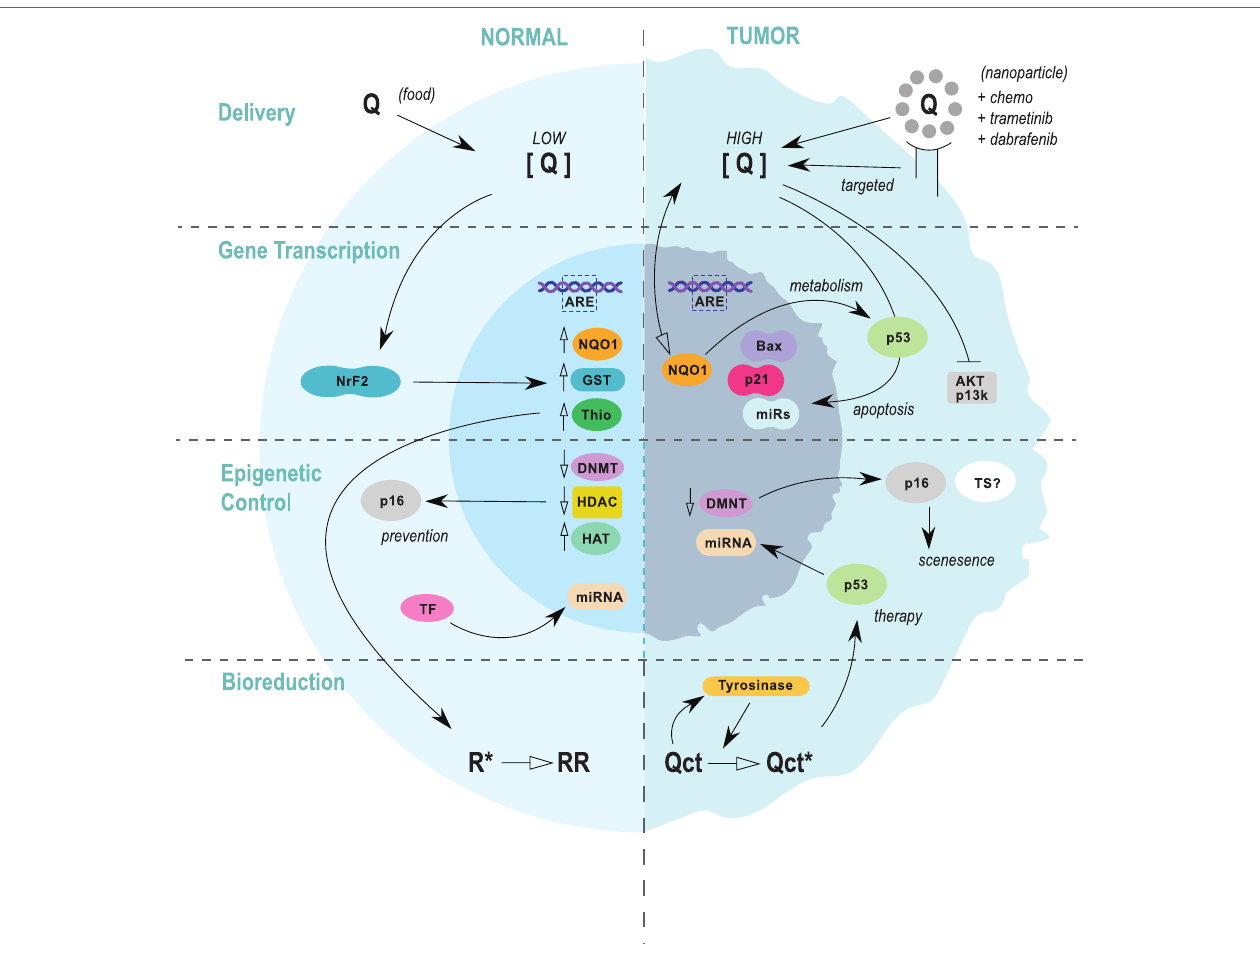
FigURe 3 | Summary of the four focus areas to develop quercetin as a chemo-preventative or therapeutic agent . In melanoma prevention scenarios (left), quercetin would be ingested through food sources and the concentration in normal melanocytes would be relatively low. Antioxidant activities and signaling pathways leading to the induction of cytoprotective proteins would dominate. Evidence suggests that quercetin may impart transcriptionally permissive epigenetic modifications within key tumor suppressor genes, including p16, which could confer resistance to oncogenesis. Induction of miRNAs could also aid in cancer prevention. In therapeutic protocols (right), quercetin would be delivered alone or in combination with anti-melanoma pharmaceuticals. Quercetin and additional compounds could be delivered through nanoparticles targeted to melanoma cells, or in an untargeted regimen. Pro-oxidant effects would be desired, and induction of wild-type p53 and other apoptotic factors would aid in therapy. Epigenetic mechanisms would likely be more prominent in prevention (blue line), but miRNAs have been shown to play a significant role in circumventing drug